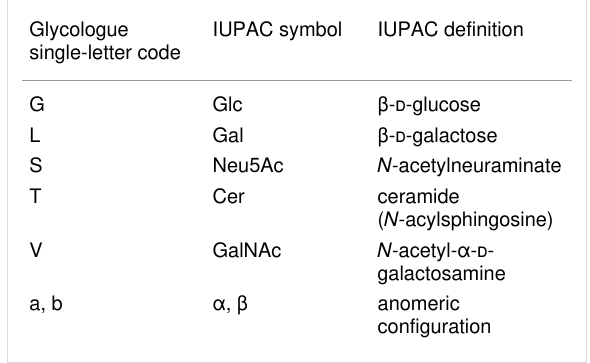
Table 1: Single-letter codes used and their IUPAC